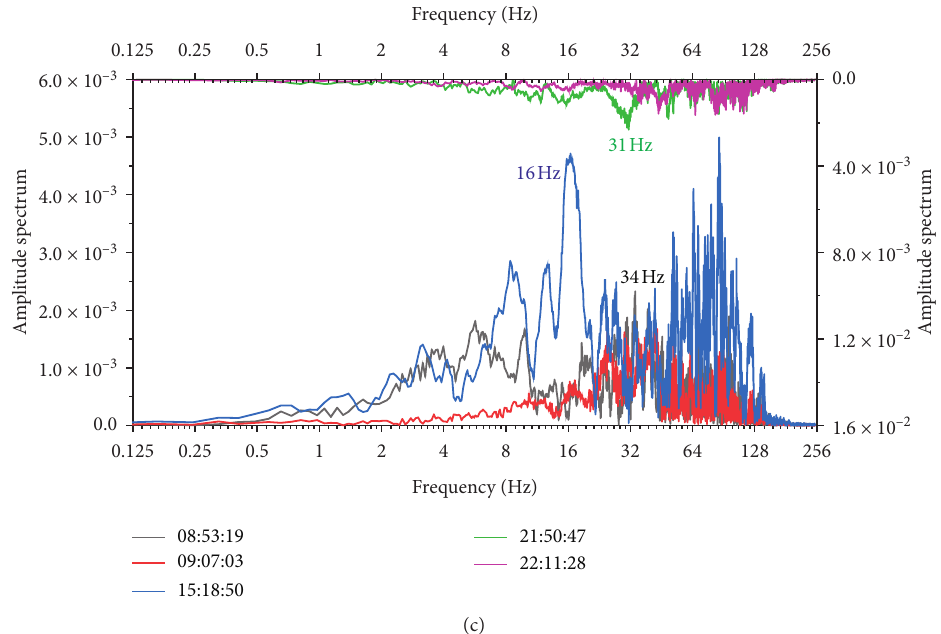
Figure 12: Frequency spectrum evolution of the MS events. (a) #16 geophone. (b) #19 geophone. (c) #21 geophone.